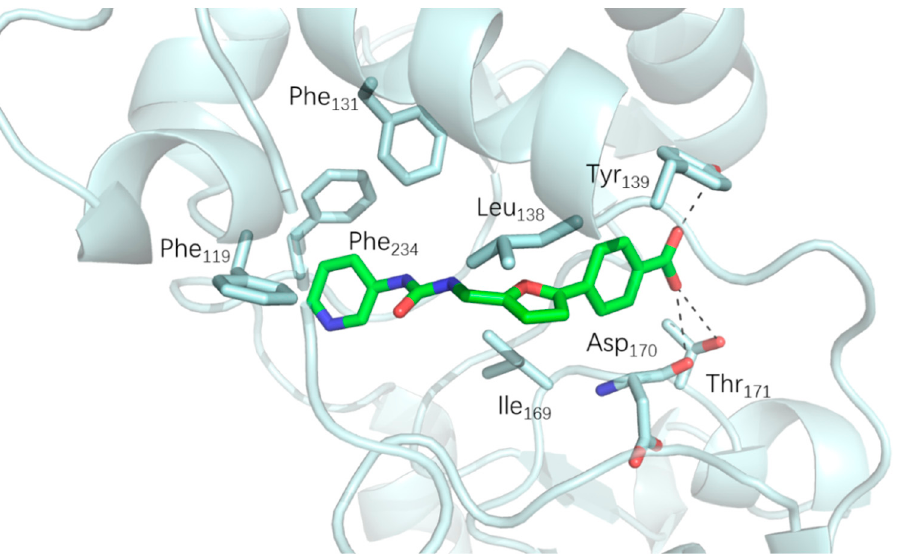
Figure 4. The docking pose of the compound 25 in the substrate binding site of SIRT2.